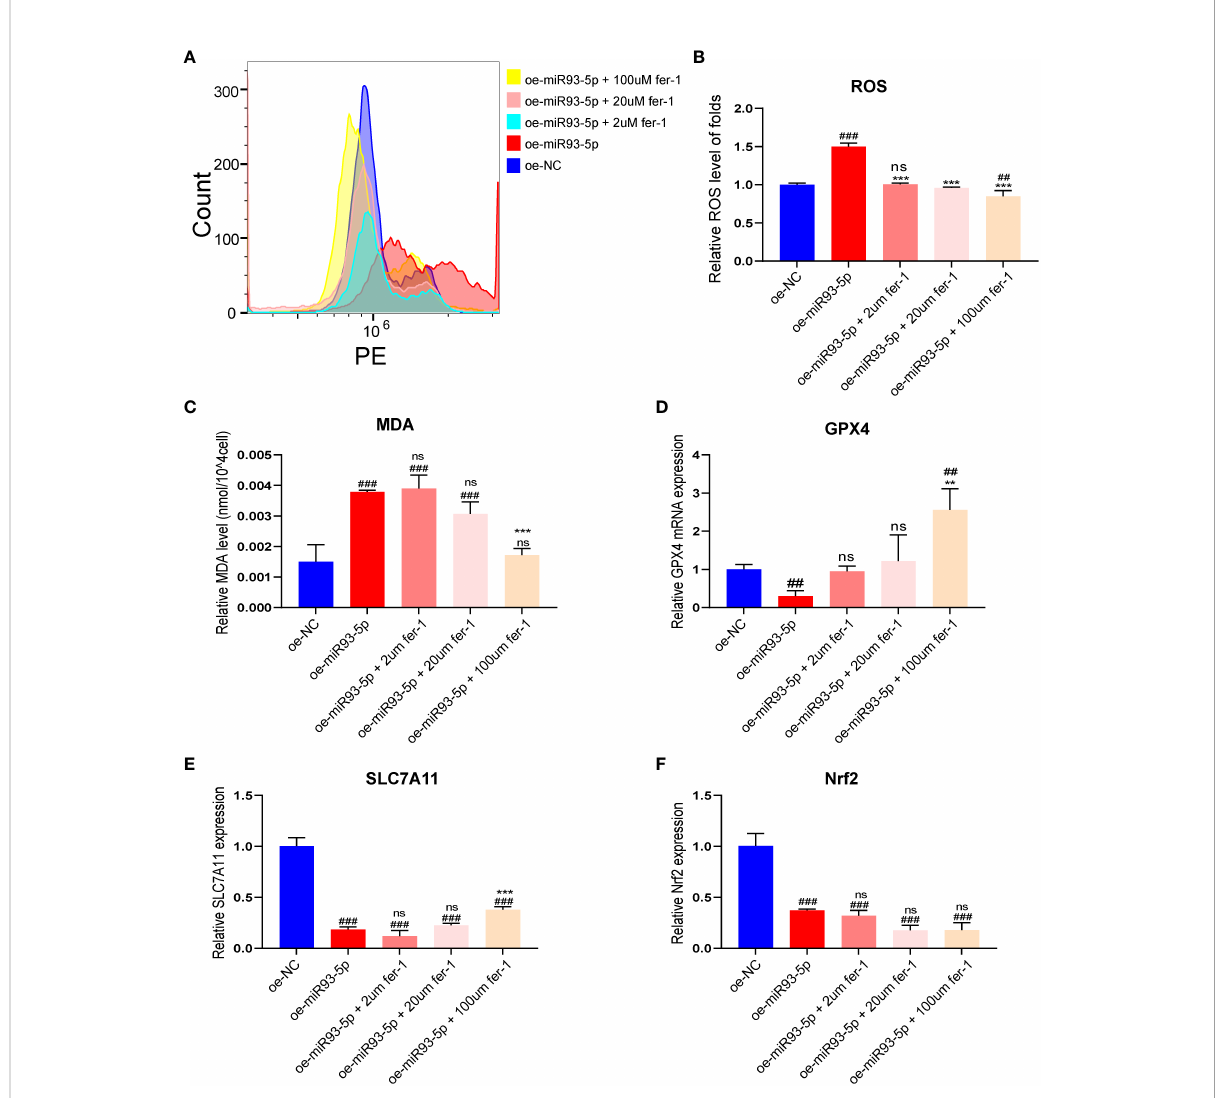
FIGURE 3 The effect of overexpression of miR-93-5p on the ferroptosis of GC. (A, B) The ROS level between the oe-NC, oe-miR93-5p and treated with fer-1 (2, 20, and 100 m M) groups. (C) MDA assay was used to detect lipid peroxidation in the presence of fer-1 (2, 20, and 100 m M) in the oe- miR93-5p group. GPX4 (D) , SLC7A11 (E) and Nrf2 (F) mRNA expression was assessed by qRT – PCR in the presence of fer-1 (2, 20, and 100 m M) in the oe-miR93-5p group. ## p < 0.01 and ### p < 0.001 compared with the oe-NC group. ** p < 0.01, *** p < 0.001 compared with the